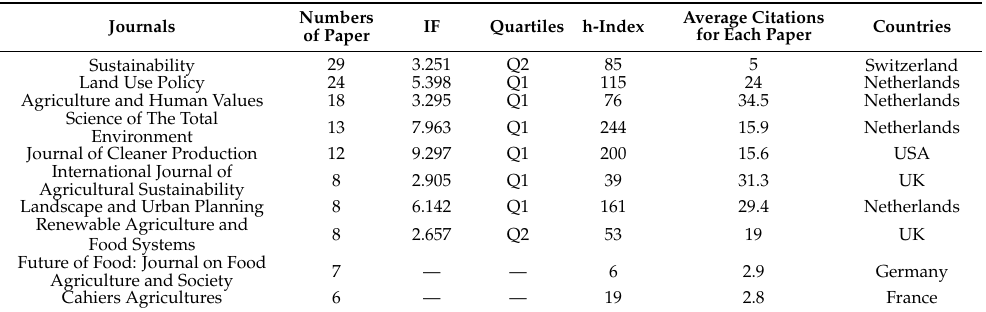
Table 2. Top 10 journals with the most articles published in the field of urban agriculture from 2001 to